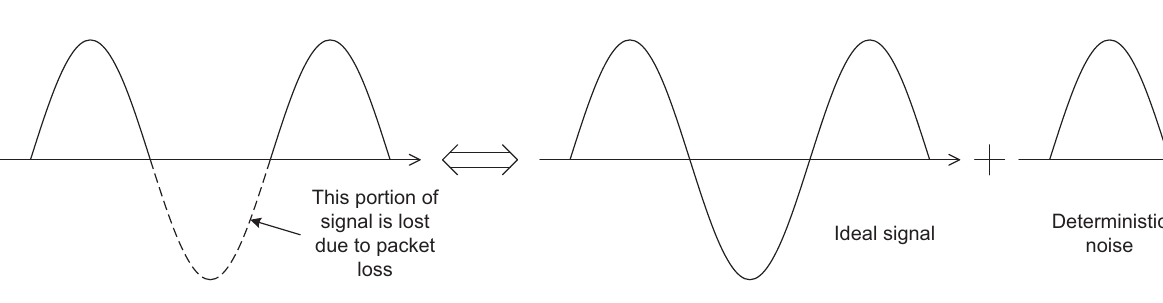
Figure 2. Modeling lost packets as